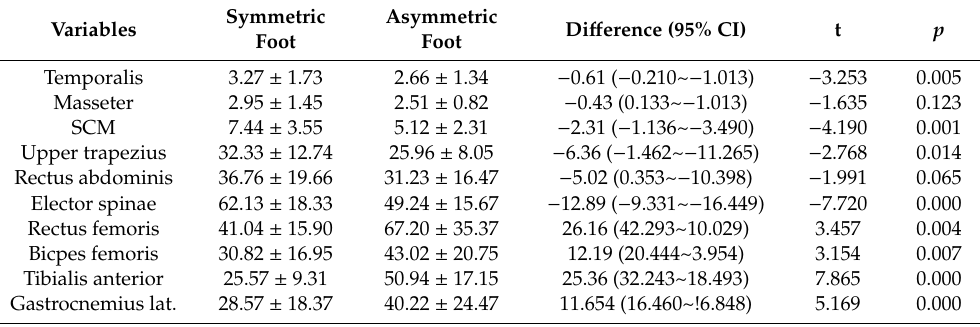
Table 2. Comparison of muscle activation between symmetric and asymmetric foot